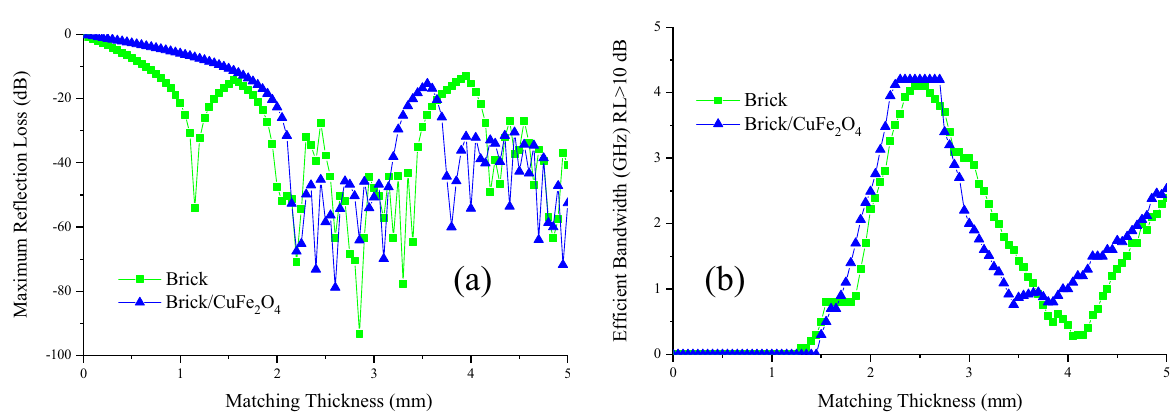
Figure 8. Frequency dependence of reflection loss and simulation of the matching thickness of the brick ( a 1, 2 ) and brick/CuFe